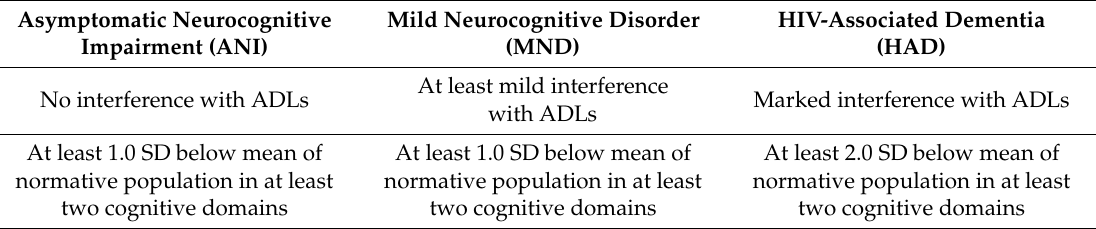
Table 2. Frascati Criteria for diagnosing HIV Associated neurocognitive disorder. ADLs; activities of daily living. SD; standard